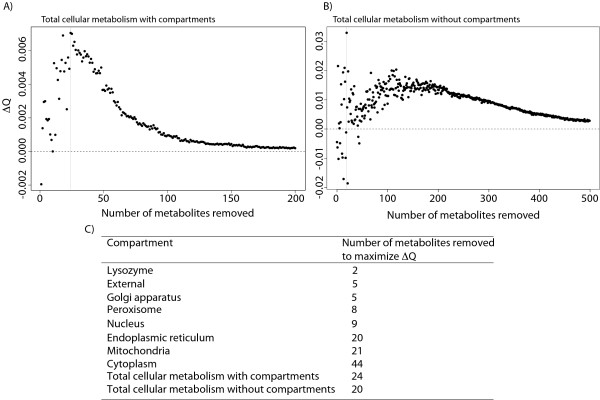
Exclusion of currency metabolites by maximizing effective modularity. Effective modularity (ΔQ; y-axis) is maximized by iteratively removing common metabolites (x-axis). The dashed horizontal line indicates the line corresponding to the ΔQ based on 1000 randomizations of the full network (ΔQ = 0). The vertical line corresponds to the number of metabolites excluded when the network modularity is maximized. A) When compartmental designations are included for each metabolite the ΔQ for the network is maximized after the 24 most frequently occurring metabolites are removed. B) When compartmental designations are not included for each metabolite the ΔQ for the graph is maximized after the 20 most frequently occurring metabolites are removed. C) Results of modularity maximization for the individual cellular compartments.